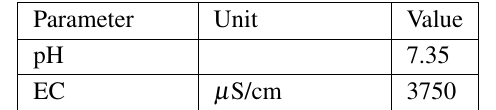
Table 1. Average brackish water analysis in the selected project